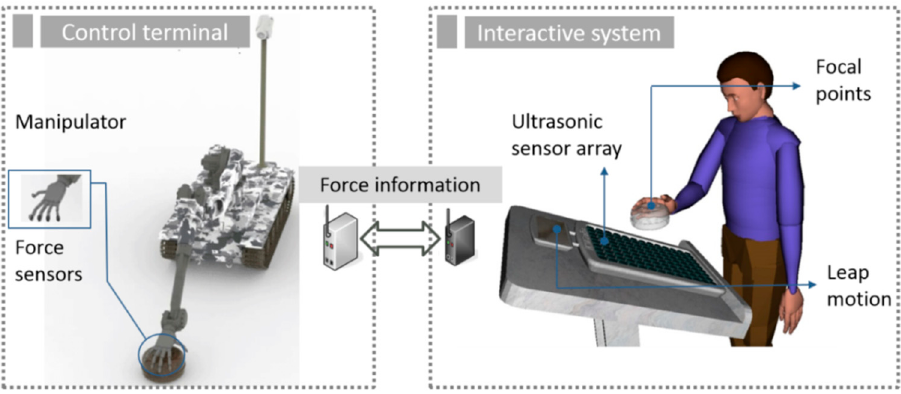
Figure 1. Conceptual diagram of teleoperation robot system.